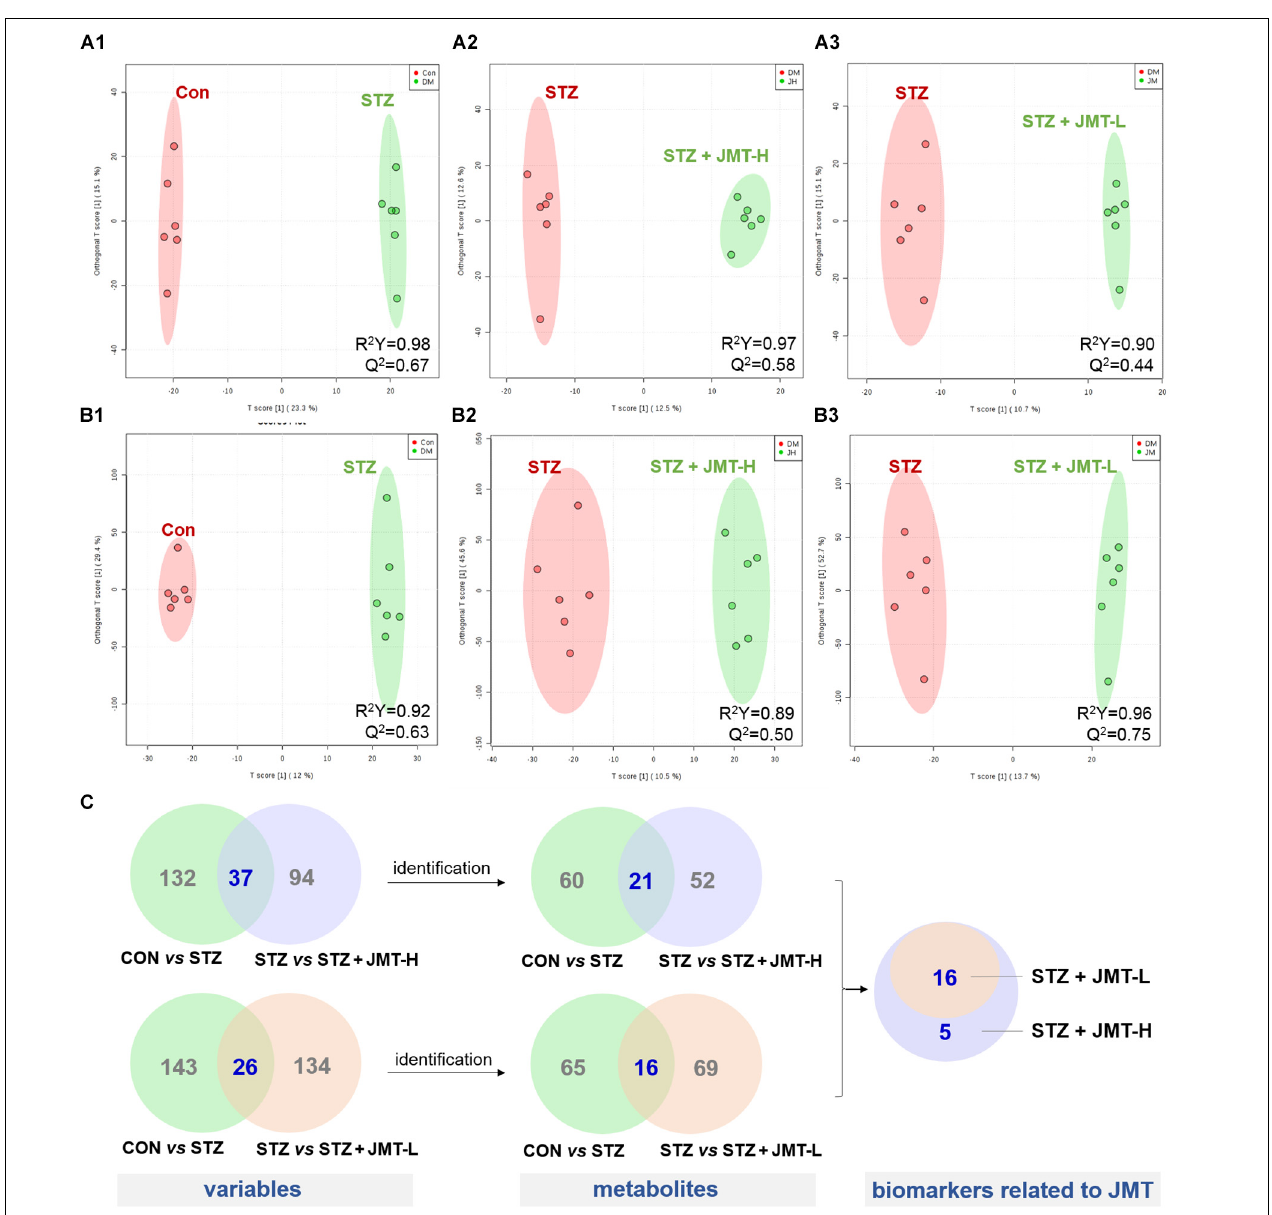
FIGURE 5 | Screening of serum metabolic biomarkers regulated by JMT decoction administration. (A,B) The score plots of OPLS-DA between Control (CON) vs. STZ groups (A1,B1) , STZ vs. STZ + JMT-H groups (A2,B2) , and STZ vs. STZ + JMT-L groups (A3,B3) in negative and positive ion modes, respectively ( n = 6 per group). (C) Venn diagram illustrated the distinct and overlapping metabolites that commonly changed in different groups. The serum levels of 16 metabolites were found to be regulated toward normal by JMT decoction administration at both low and high dosage, while another 5 metabolites were regulated just by JMT decoction at high